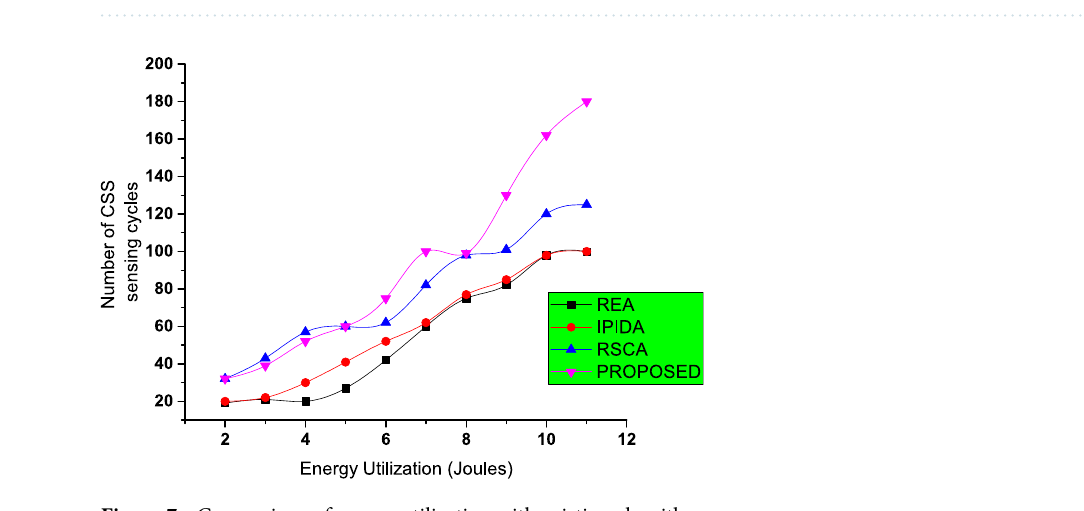
Figure 6. Average number of sensing nodes with α = 1.5 and γ = 2.5 with varying number of nodes.